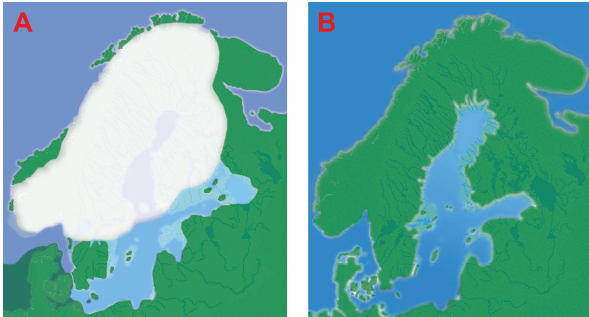
Figure 2. (a) Estimated extension of the Scandinavian ice sheet at 11.7kyBP just prior to the final drainage of the Baltic Ice Lake. Dark blue: Atlantic Ocean, light blue: Baltic Ice Lake. (b) Exten- sion of the Littorina Sea during the time of maximum salinity in the Baltic basin at ca. 6kyBP. Source: Andrén et al.